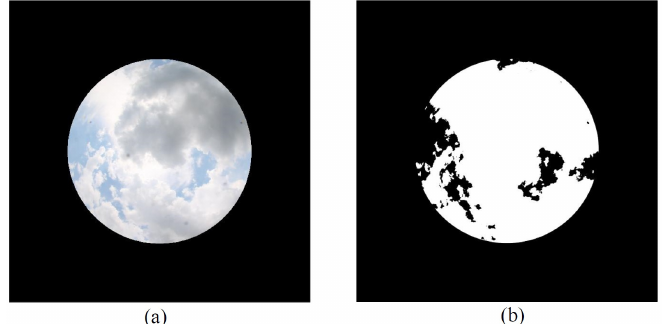
Figure 10. Segmentation of a sky image: ( a ) original image after mask, ( b ) image after segmentation. Figure 11 plots the probability density of normalized SWV associated with clear sky and cloudy conditions on 16 April 2016. The histogram shows the actual probability distri- bution, along with the smoothed probability density curves. The figure shows that there is a notable right shift in the distribution of normalized SWV for cloudy conditions com- pared to that for clear sky conditions. The mean normalized SWV for cloudy conditions is around 62 mm while for clear sky conditions, it is around 57 mm. To include more samples, Figure 12 further plots the probability density normalized SWV associated with clear sky and cloudy conditions for the months of April and May 2016. With more samples, the dis- tribution of normalized SWV has a wider spread compared to the single-day samples from earlier. In general, the daily mean of the normalized SWV may fluctuate according to the water vapor level within the atmosphere, hence the wider spread and closer peaks between the clear sky and cloudy conditions. Nevertheless, the right shift in the distribution for cloudy condition compared to that for clear sky condition is visible. The mean normalized SWVs for cloudy and clear sky conditions are around 60 mm and 56 mm, respectively. The difference at around 4 mm is rather consistent with the difference in the mean PWV values between rain and no rain conditions at around 2 to 4 mm for the NTUS station in [28]. Overall, the distribution of the normalized SWV shows that its mean values associated with cloudy conditions are higher than those associated with clear